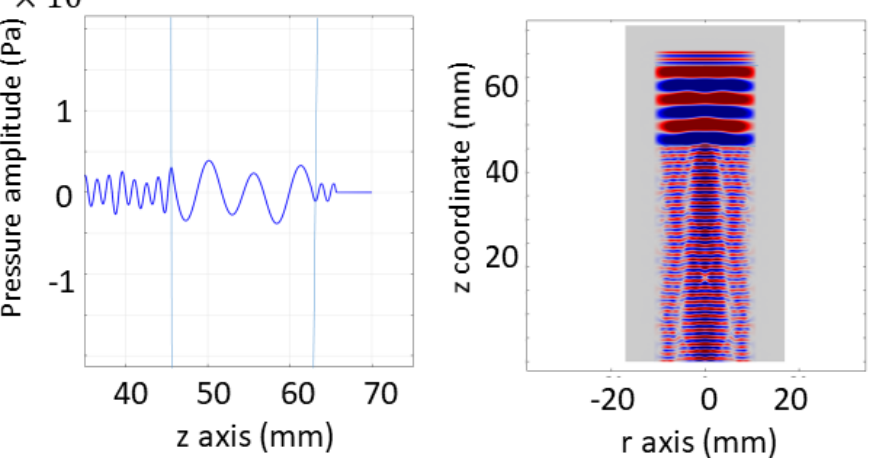
Figure A2. Simulated pressure amplitude for a 20 mm thick glass slide. The blue bars represent the glass slide edges. A 5% amplitude drop is expected for this thickness. No clear difference inside the glass is observed, which is coherent with attenuation by absorption being almost negligible.